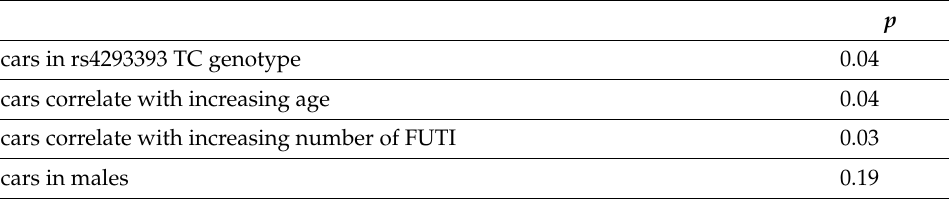
Table 4. Multiple logistic regression analysis considering the presence of scars as